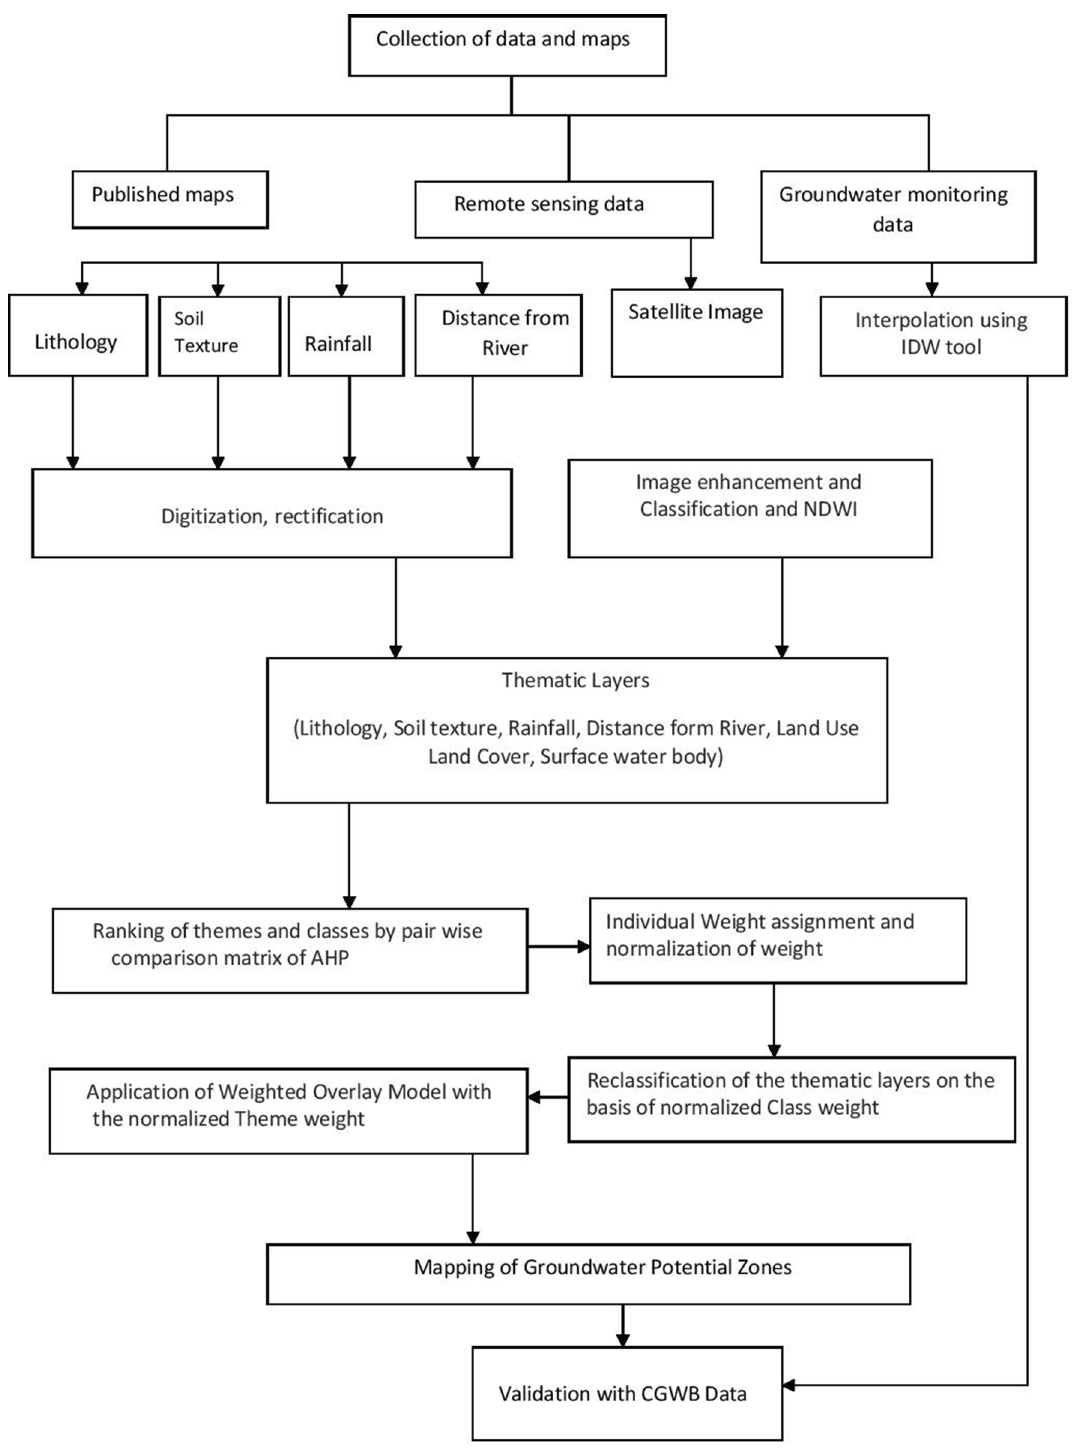
Fig. 2 Flowchart of